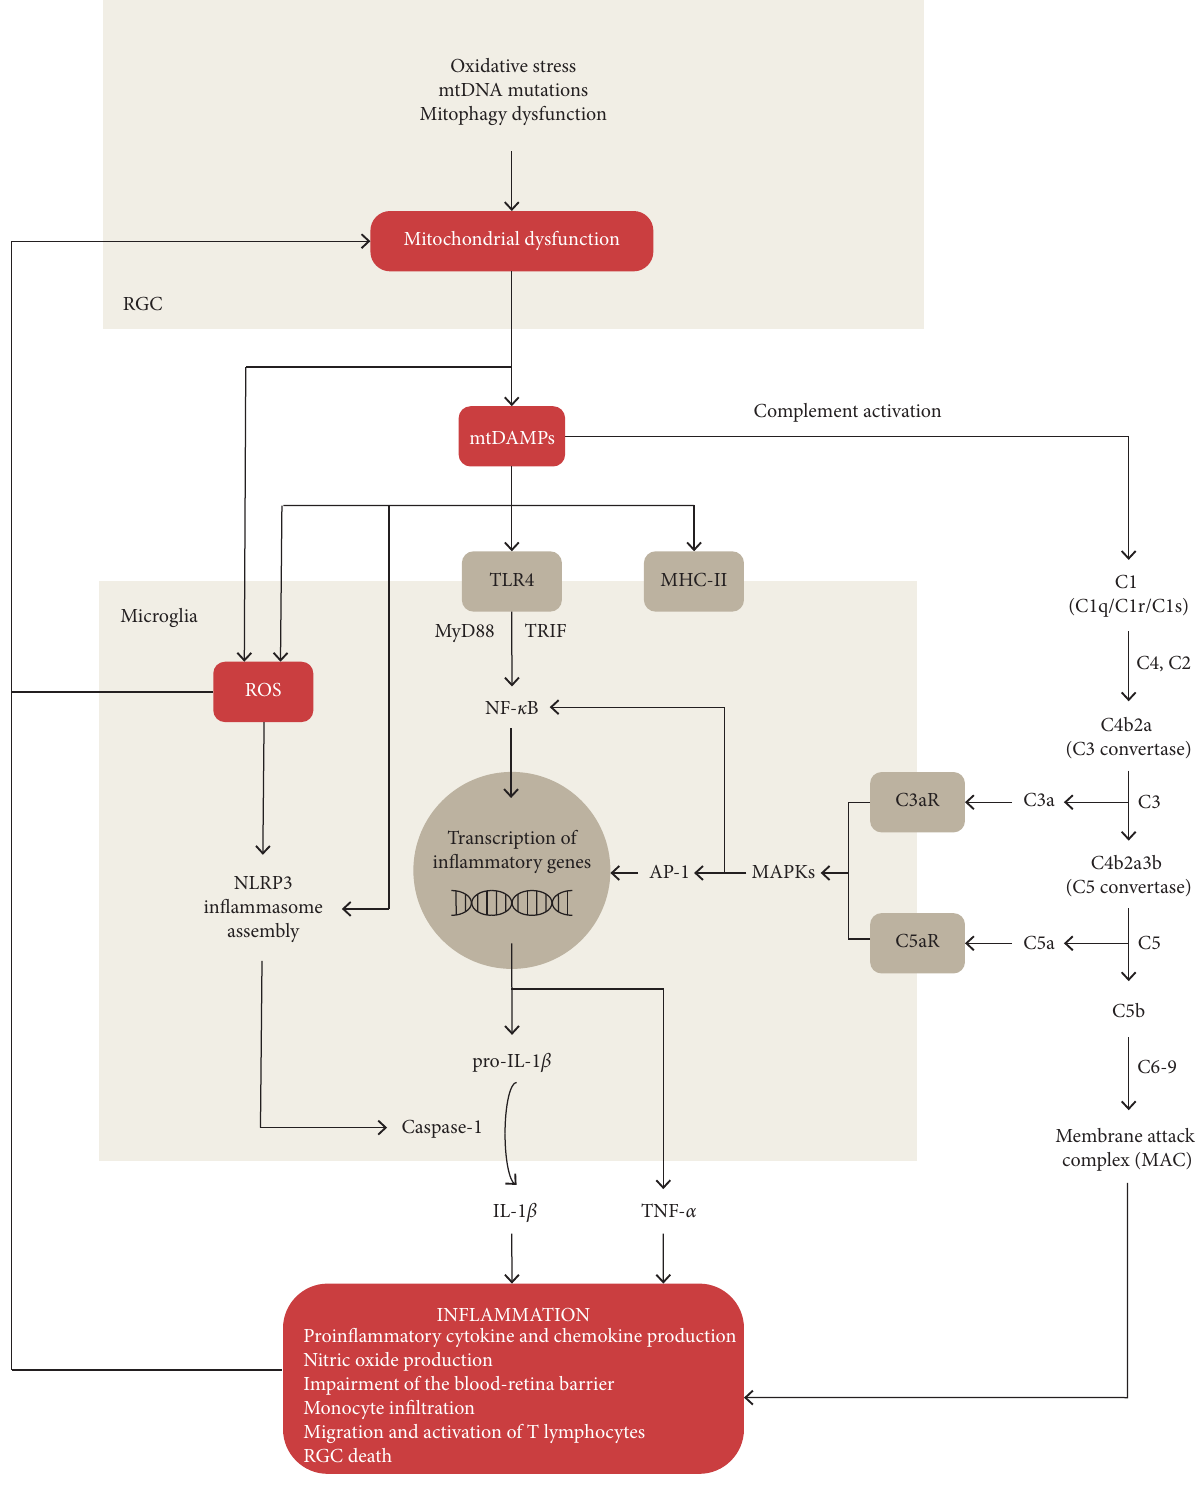
Figure 2: Neuronal mitochondrial damage-associated molecular patterns (mtDAMPs) can act as inducers of chronic inflammation in glaucoma. Mitochondrial-derived components from retinal ganglion cells (RGCs) can trigger inflammatory responses when recognized by complement molecules (classical pathway) and microglial pattern-recognition receptors, such as toll-like receptors (TLRs). TLR signaling induces the transcription of proinflammatory cytokines and chemokines (e.g., pro-IL-1 β and TNF- α ) through NF- κ B. Inflammation triggered by mtDAMPs can further induce mitochondrial dysfunction, thereby amplifying a vicious cycle of inflammation. In addition to TLR signaling, the presentation of DAMPs through Class II MHC (MHC-II) molecules can further promote the induction of inflammation through T-cell activation. Mitochondrial products can also function directly as NLRP3 activators, which allows caspase-1-dependent release of IL-1 β . AP-1: activator protein-1; MAPKs: mitogen-activated protein kinases; C3aR: C3a receptor; C5aR: C5a